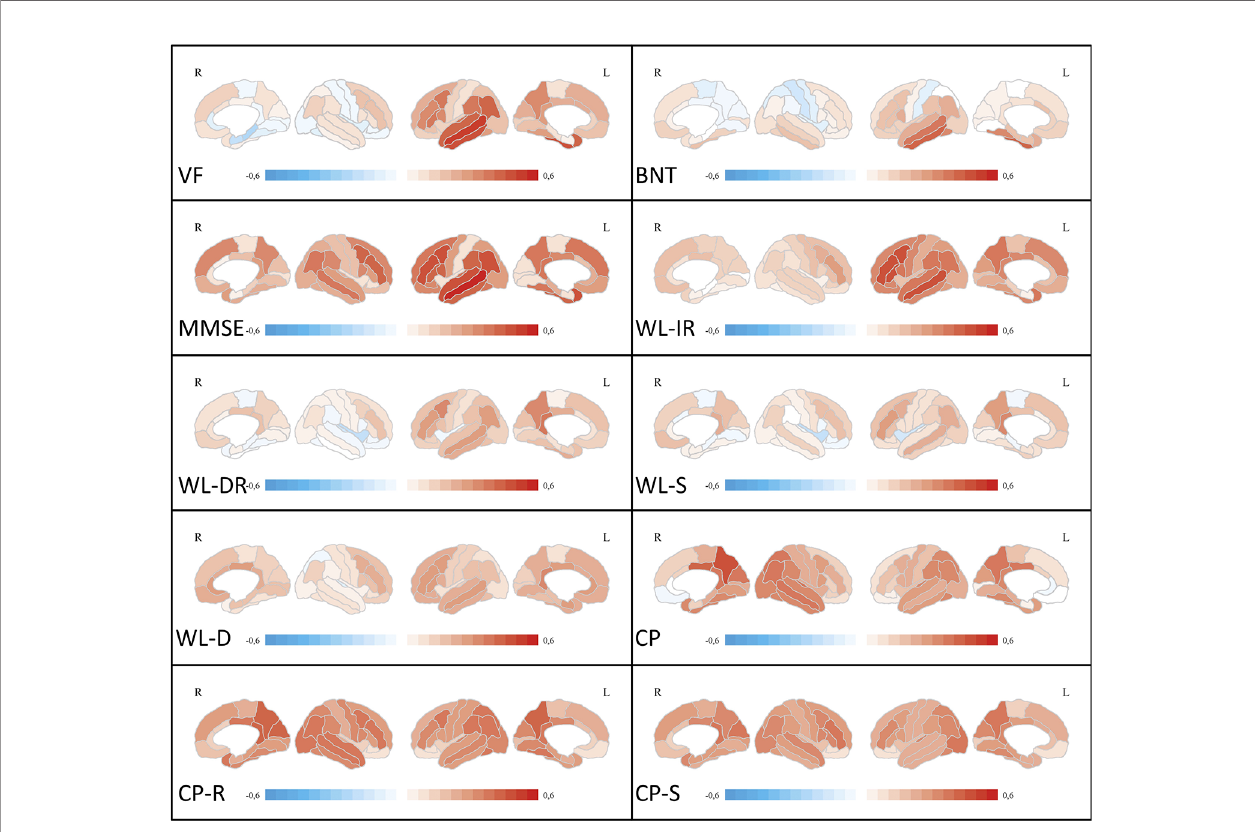
FIGURE 2 | Correlation analyses between ROI-based FDG uptake and neuropsychological test scores. Medial and lateral projections of the right and left hemisphere are shown. Red color depicts positive correlations (Pearson ’ s r), blue color depicts negative correlations. Maximum Pearson ’ s r is set at -0.6 and 0.6, respectively. Verbal fl uency (VF), Boston Naming Test (BNT), Mini-Mental State examination (MMSE), Word List Immediate Recall (WL-IR), Word List Delayed Recall (WL-DR), Word List Savings (WL-S), Word List Discriminability (WL-D), Constructional Practice (CP), Figures Recall (CP-R), Figures Savings (CP-S). FDG, [18F]- fl uorodeoxyglucose; ROI, region of